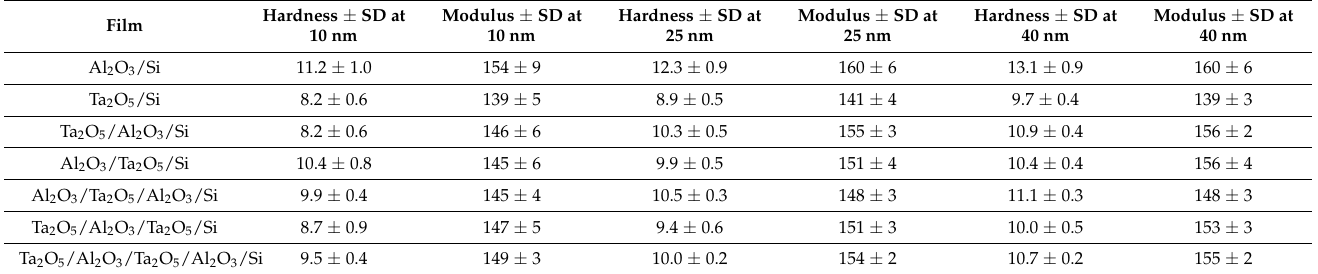
Table 3. Average hardness and reduced modulus with standard deviation (SD) at various